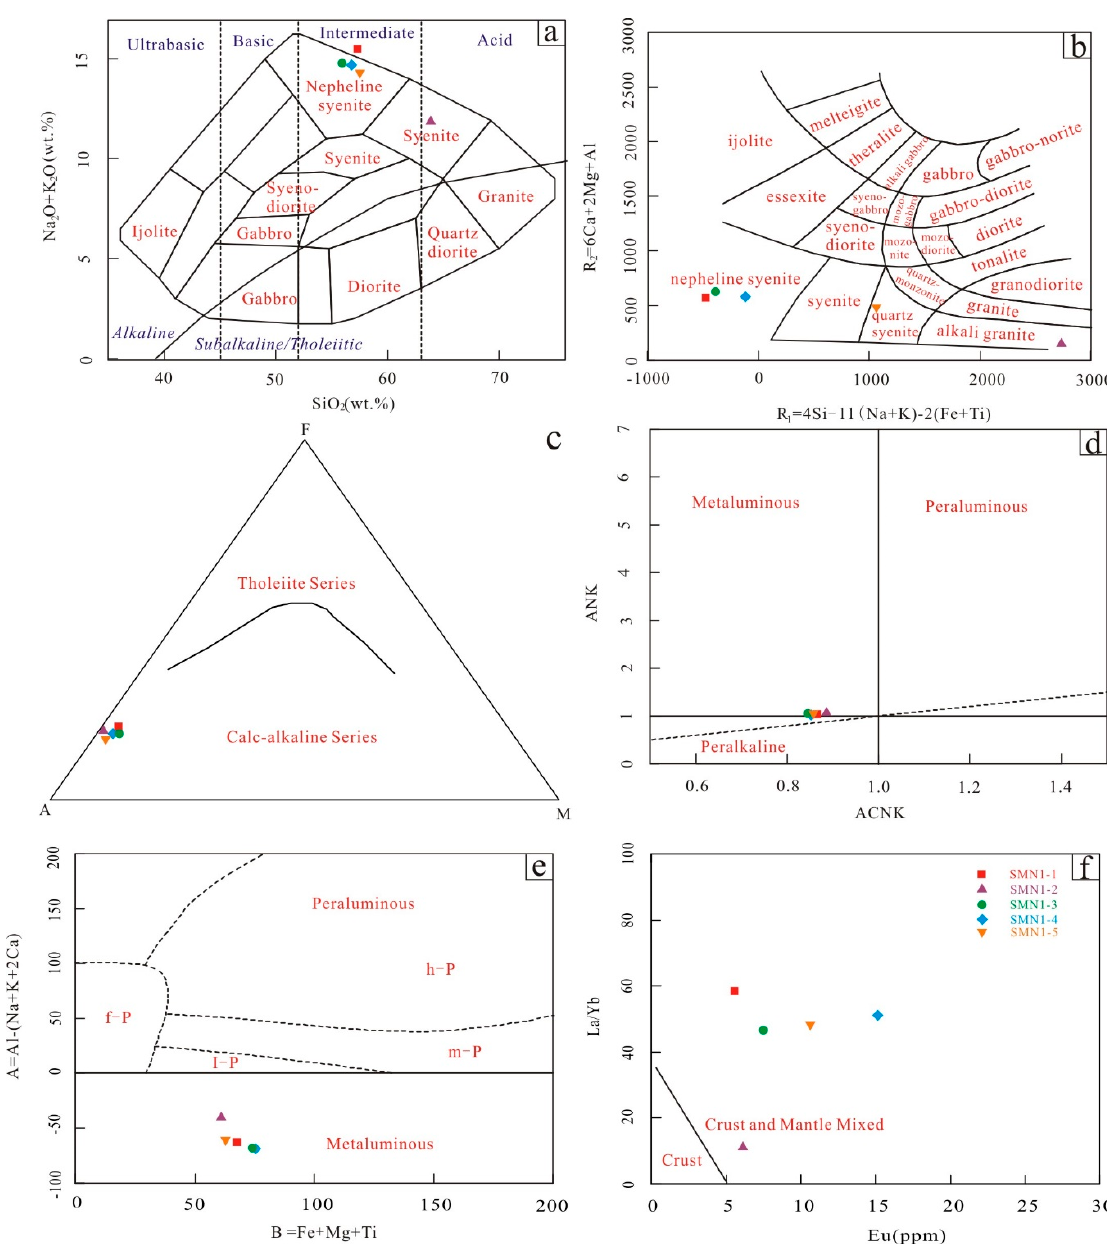
Figure 5. Geochemical classification diagrams for the syenites in the Saima deposit. ( a ) TAS diagram. ( b ) R2 vs. R1 diagram. ( c ) FAM diagram. ( d ) A/NK vs. A/CNK diagram. ( e ) [Al − (Na + K + 2Ca)] vs. (Fe + Mg + Ti) diagram. ( f ) La/Yb vs. Eu diagram (after Le Maître 1989; after Middlemost, 1994; after Irvine, 1971) [11–13].